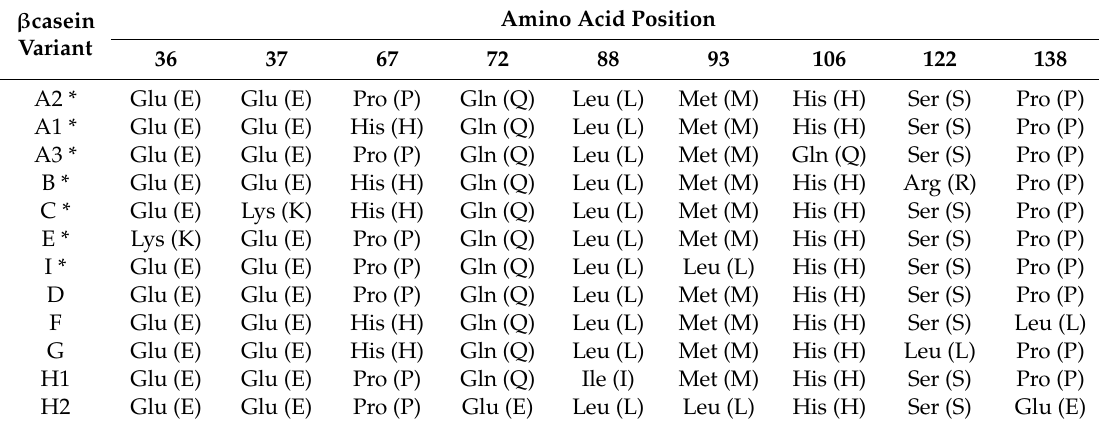
Table 1. The change in the amino acid sequence of β -casein variants (in bold: amino acid variations). β casein